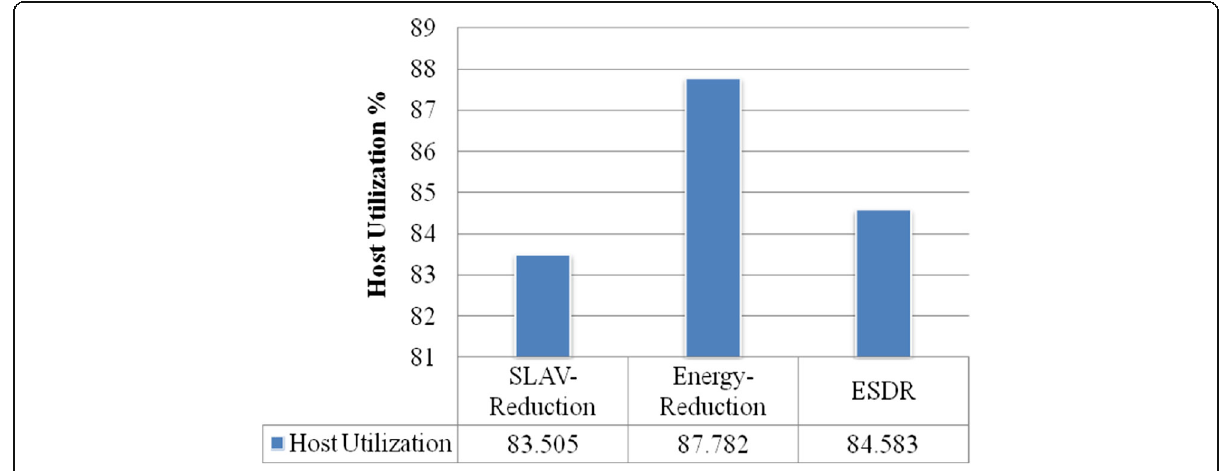
Fig. 1 Comparison of Host Utilization metric in different approaches